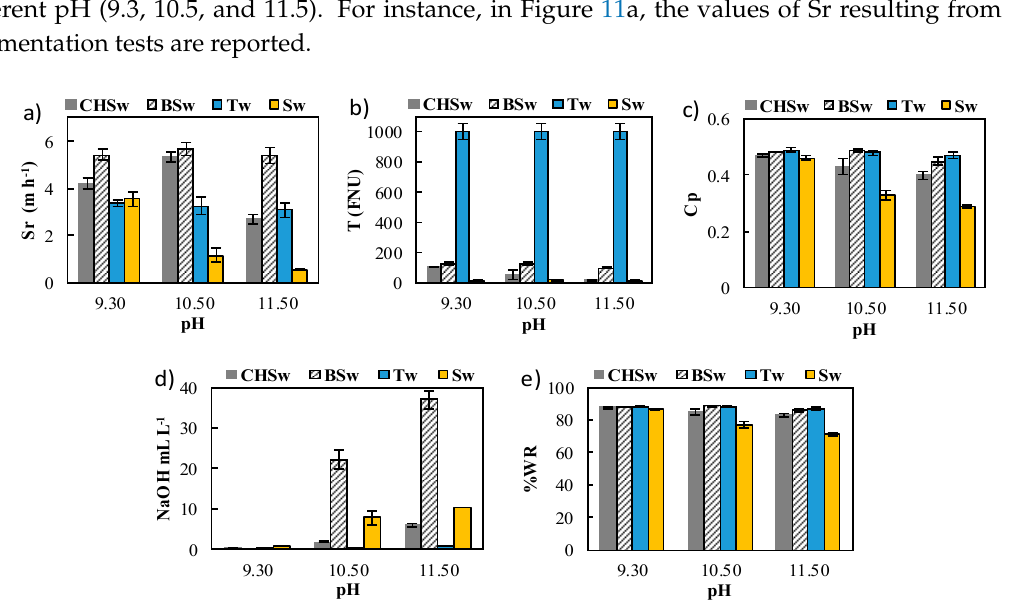
Figure 11. Process performance parameters ( a ) Settling rate (Sr), ( b ) Turbidity (T), ( c ) Solid fraction (Cp), ( d ) NaOH consumption, ( e ) Water recovery percentage (%WR) in sedimentation tests and different aqueous media (i.e., Chemically pretreated seawater (CHSw), Pretreated seawater by biomineralization (BSw), Tap water (Tw) and Raw Seawater (Sw) at different pH values (i.e., 9.3, 10.5, and 11.5).